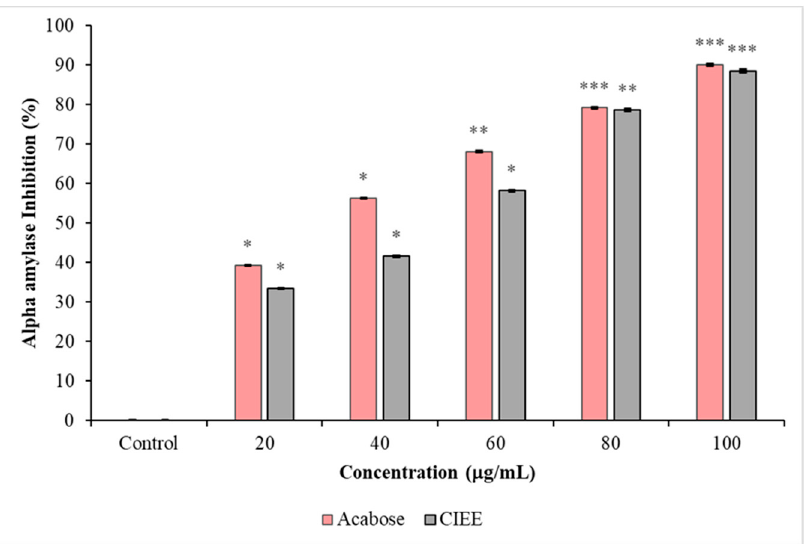
Figure 4. The effect of ethanolic extract of C. incana on α -amylase activity. CIEE: Calamintha incana ethanolic extract, Acarbose: positive control. Data represented as the mean ± SD (N = 3). * p < 0.05, ** p < 0.01, *** p < 0.001 vs. untreated enzyme (control) (ANOVA, Tukey’s post hoc test).